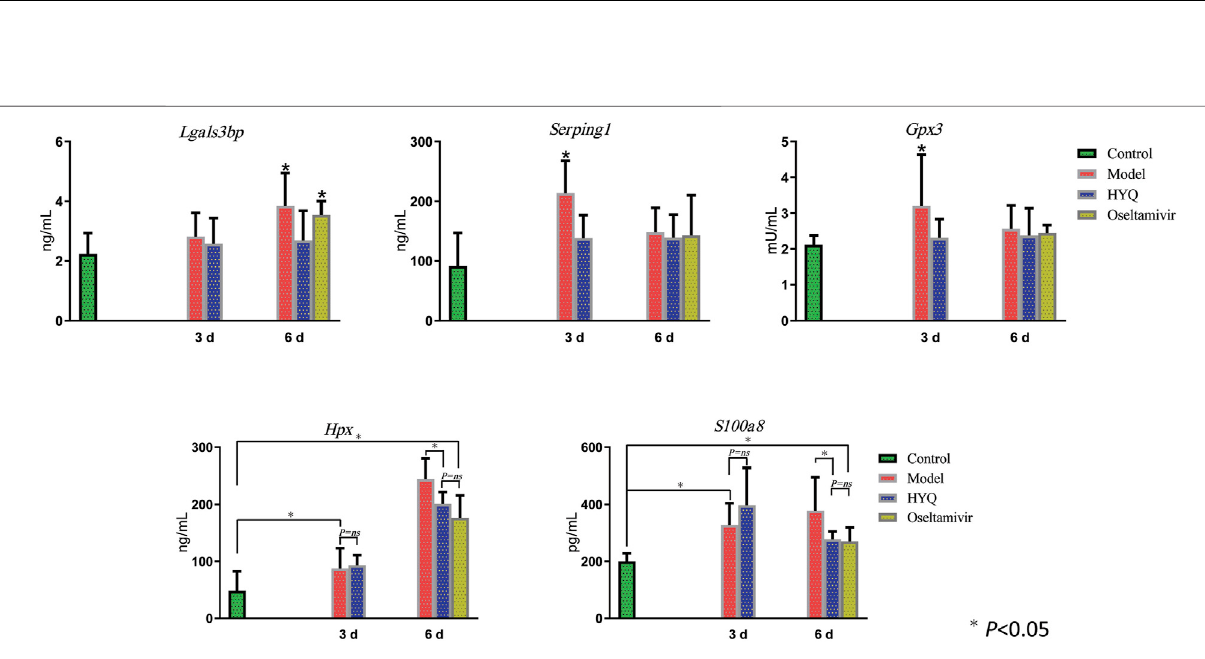
Frontiers in Pharmacology |